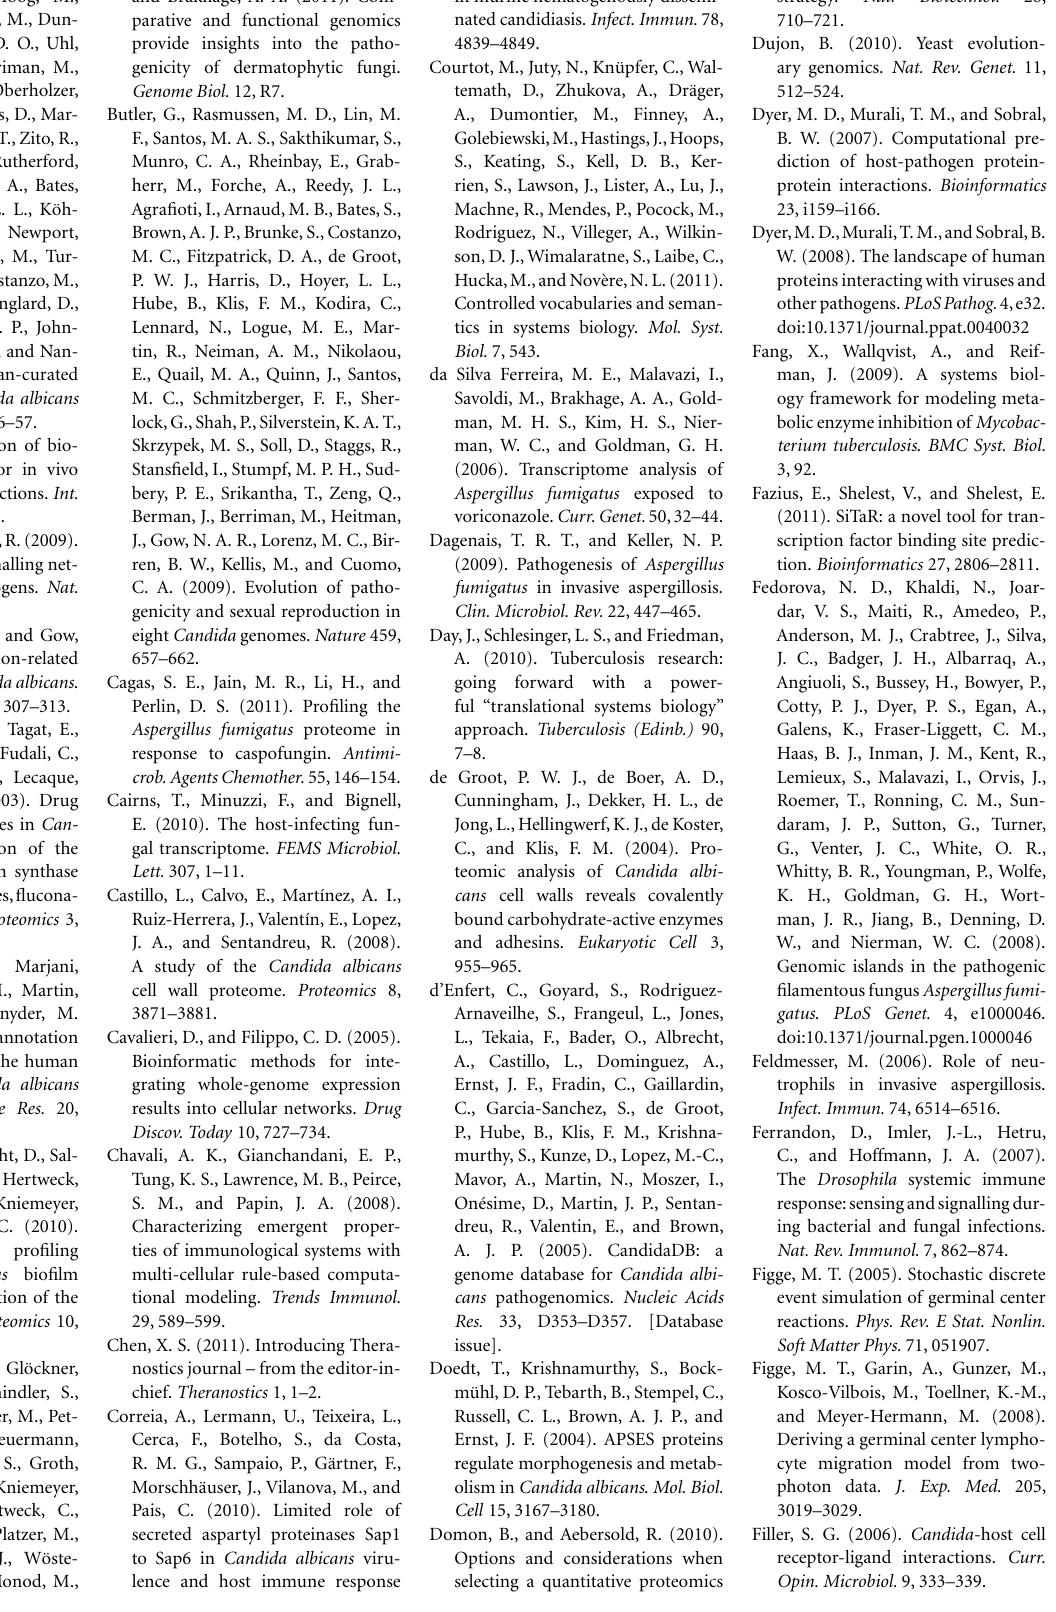
Figge, M. T. (2005). Stochastic discrete event simulation of germinal center